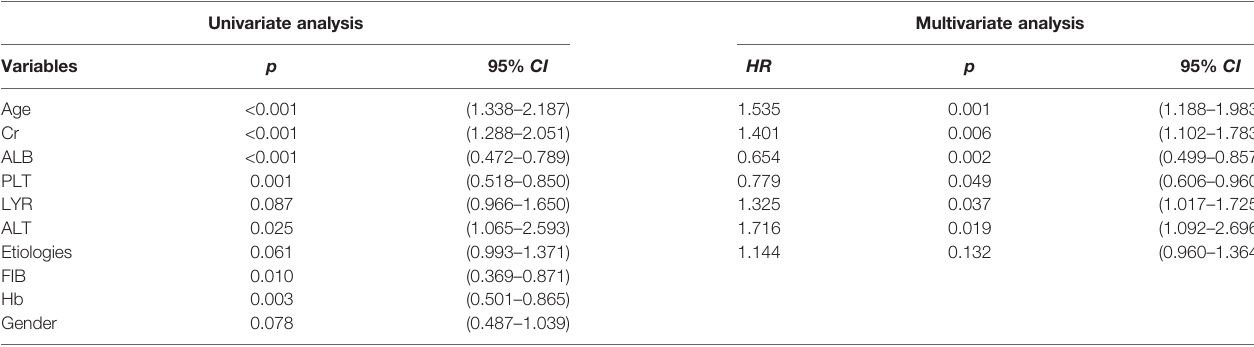
TABLE 2 | Univariate and multivariate analyses in the derivation